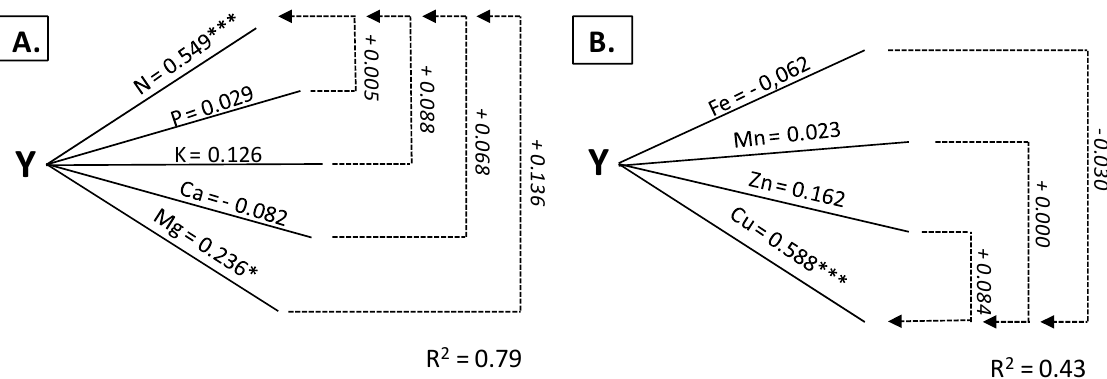
Figure 3. Path diagram of the impact of macronutrients ( A ) and micronutrients ( B ) contents in potato stems at the onset of tuberization on the marketable tuber yield. *** , ** , * significant at p < 0.001; < 0.01; < 0.05, respectively.